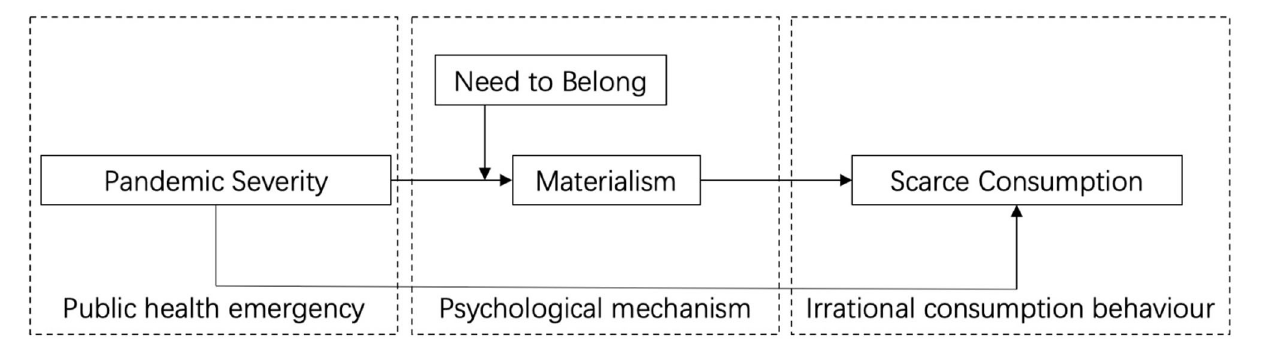
FIGURE 1 | Theoretical model.